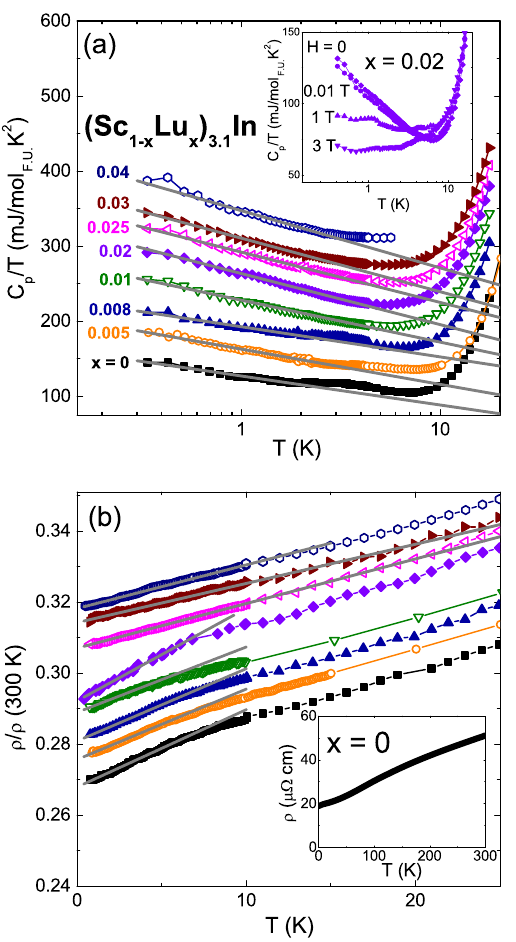
=T (symbols) FIG. 9. (a) Semilog plot of the specific heat C p and the linear fits (lines) at low temperatures. The data for x > 0 K 2 . Inset: are shifted vertically for clarity by 30 mJ = mol F : U : Þ Specific heat for ð Sc 0 Lu 0 3 . 1 In in various magnetic fields: . 98 . 02 H ¼ 0 , 0.01, 1, and 3 T. (b) Temperature-dependent resistivity Þ 0 ≤ x ≤ 0 . 04 ). The data are shifted verti- for ð Sc 1 − Lu 3 . 1 In ( x x cally for clarity. Inset: The whole range of ρ ð T Þ from which residual resistivity ratios (RRR) are